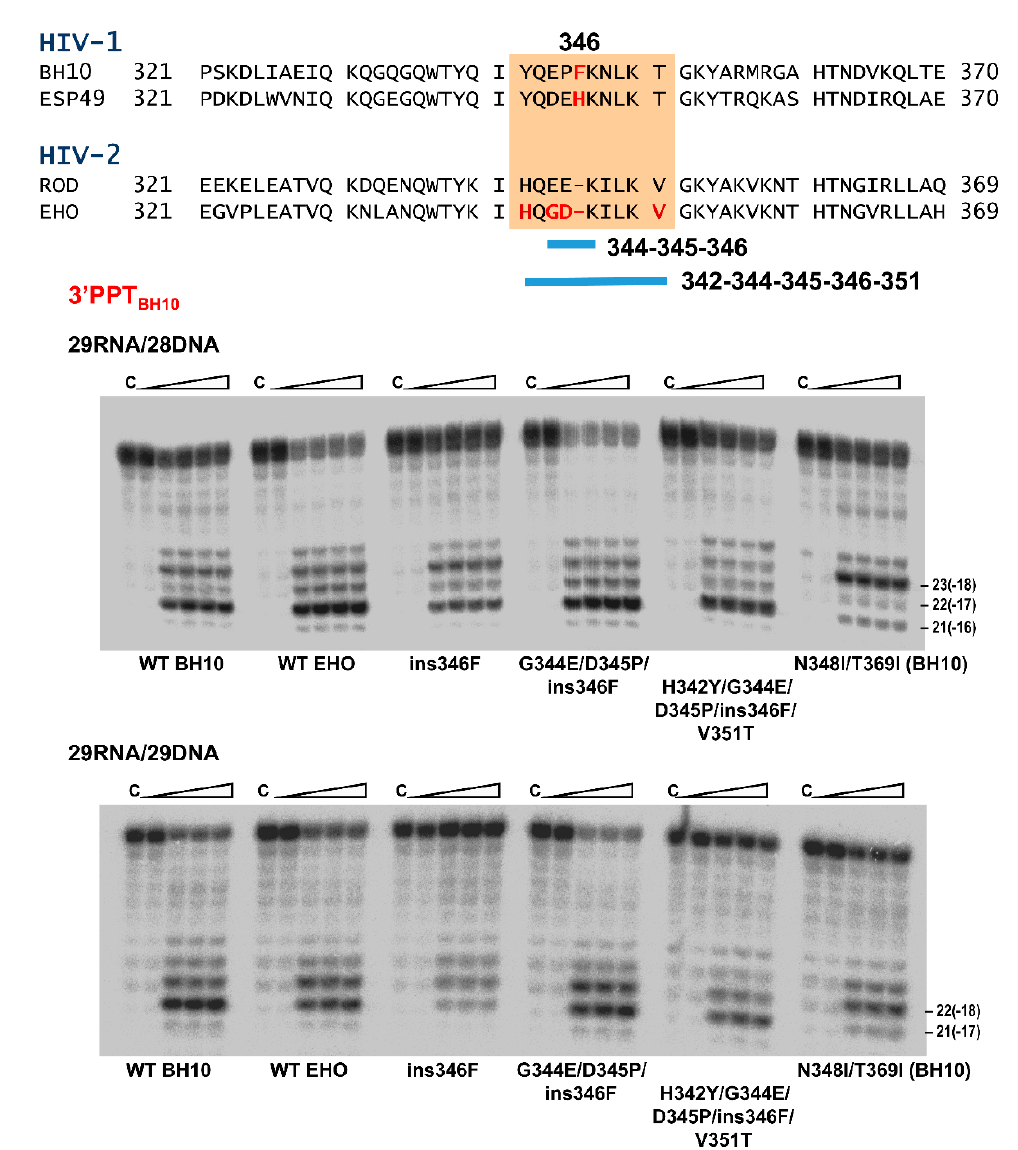
Figure 8. Effect of amino acid substitutions in the connection subdomain of HIV-2 EHO RT on the RNase H cleavage window. Amino acid sequence differences between representative HIV-1 and HIV-2 RTs are shown above. Sequence differences at positions 342-351 (HIV-1 RT numbering) are highlighted in an orange background. Gels below show representative RNase H cleavage assays carried out with 29RNA/28DNA and 29RNA/29DNA hybrids mimicking sequences found in the 3 ′ PPT of HIV-1 BH10 (see Figure 4A for details). Assayed mutants were obtained in the HIV-2 EHO RT background, except in the case of N348I/T369I which was made in the HIV-1 BH10 RT. Reactions were carried out in the presence of RT and template-primer at concentrations of 125 nM and 25 nM, respectively. RT and template-primer were pre-incubated for 5 min at 37 °C, and aliquots were withdrawn at 0, 20, 40 and 180 s after the addition of magnesium and heparin. Lane C shows control experiments including heparin in the pre-incubation buffer.